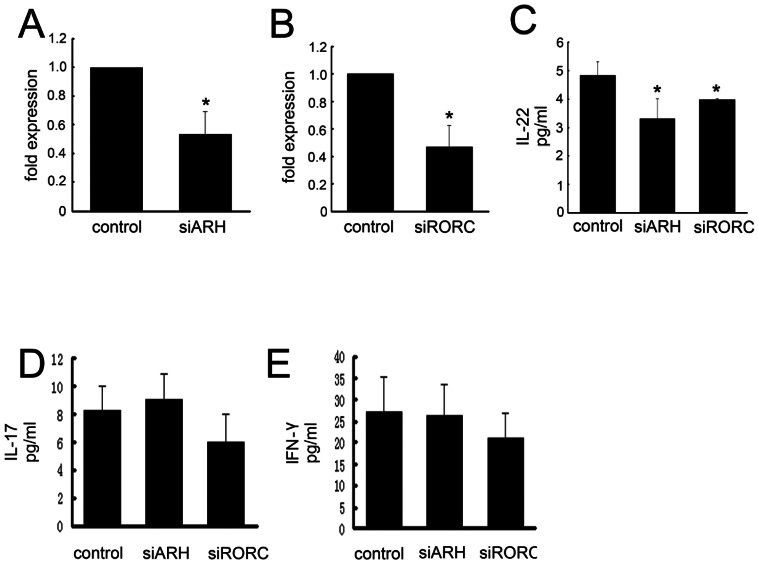
Knockdown of RORC or AHR in CD4+ memory T cells has different effects on the production of IL-22, IL-17, and IFN-γ.(A) qRT-PCR analysis of the AHR mRNAs in CD4+ memory T cells at 48 h after transient transfection of AHR-specific(n = 5/per group) , *P<0.05. (B). qRT-PCR analysis of the RORC mRNAs in CD4+ memory T cells at 48 h after transient transfection of RORC-specific(n = 5/per group). Data are presented relative to expression in cells transfected with non-targeting siRNA (control), *P<0.05. (C) ELISA of IL-22 cytokine secretion by siRNA-transfected CD4+ memory T cells(n = 5/per group) , *P<0.05. (D) ELISA of IL-17 cytokine secretion by siRNA-transfected CD4+ memory T cells(n = 5/per group). (E) ELISA of IFN-γ cytokine secretion by siRNA-transfected CD4+ memory T cells(n = 5/per group).